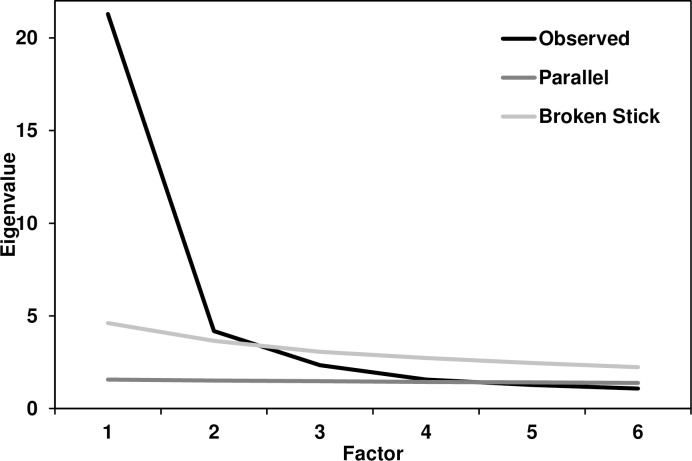
Close-up of Fig 1.Close-up of Fig 1 showing scree plots of Eigenvalue by the first six factors: Observed, parallel analysis, and broken-stick analysis.